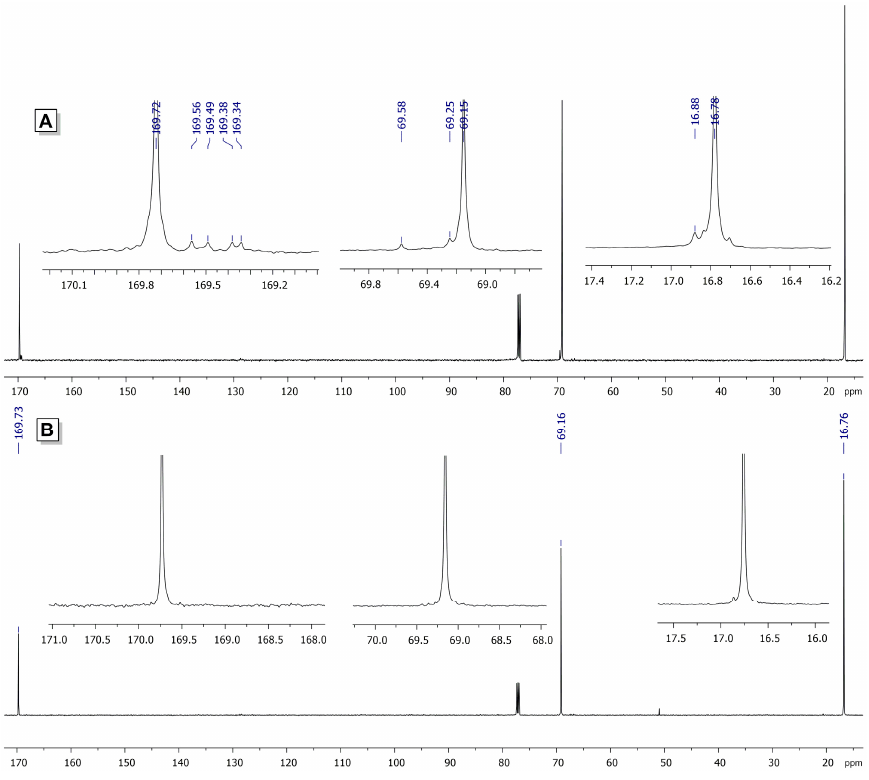
Figure 1. 13 C NMR spectra (CDCl 3 , 20 °C) of PLLA obtained in the presence of 1 ( A ) and 3 ( B